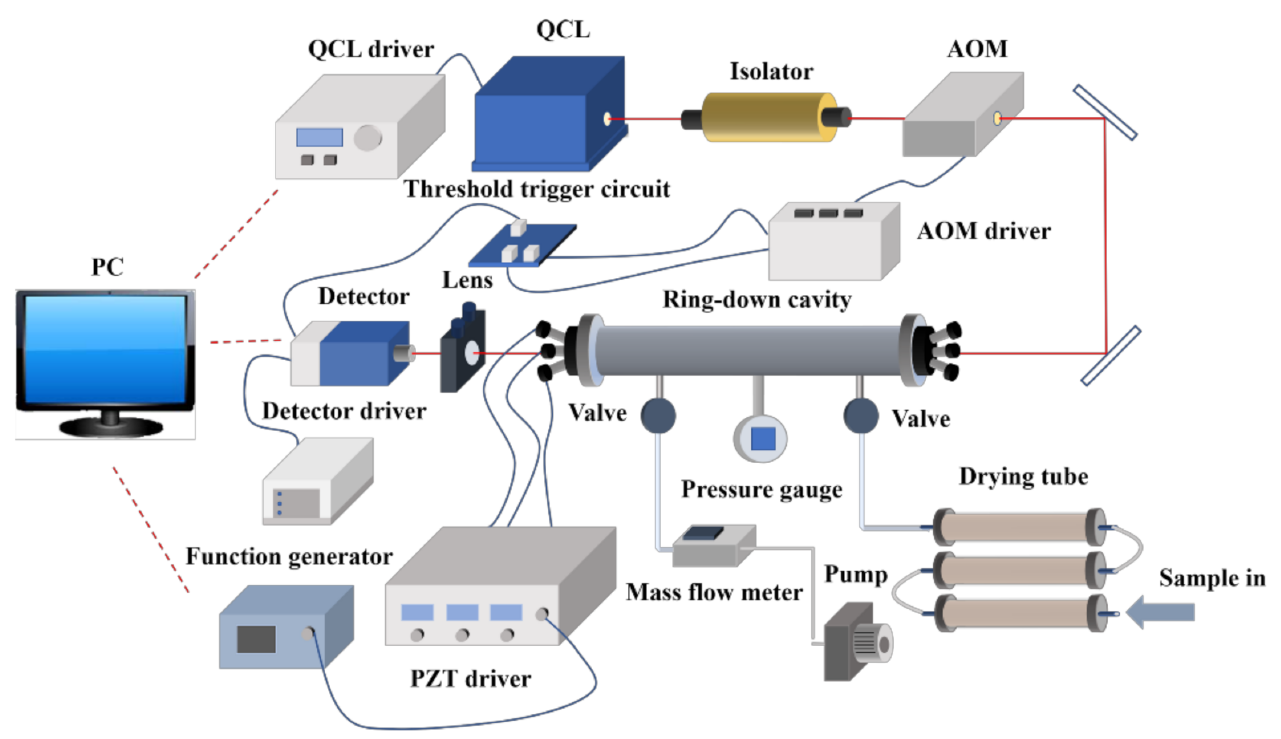
Figure 2. Schematic diagram of the cavity ring-down spectroscopy (CRDS) experimental